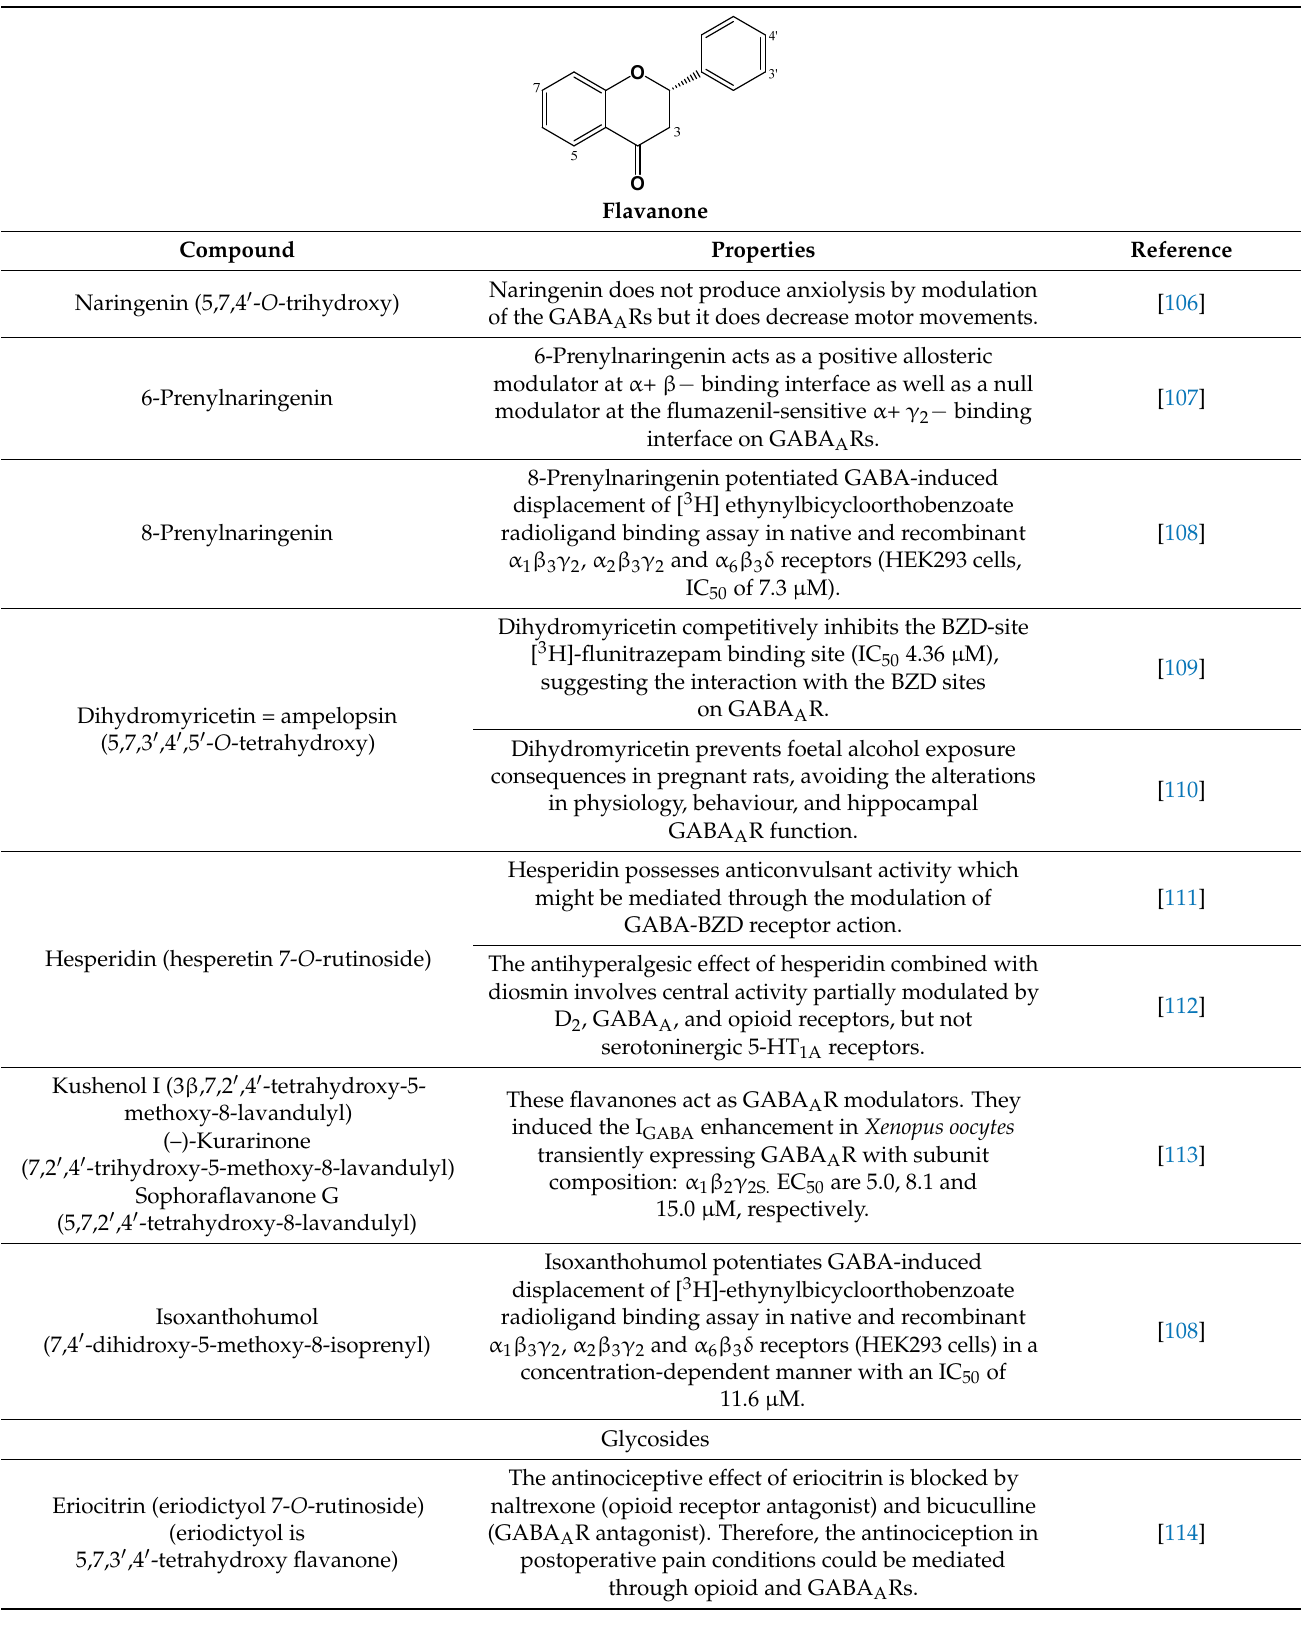
Table 3. Flavanones with relevant GABAergic effects.